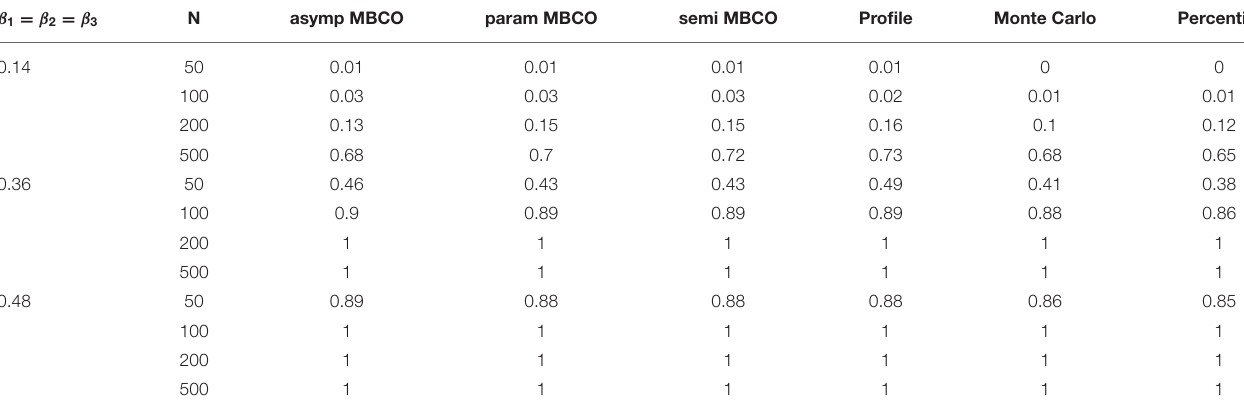
100 1 1 1 1 1 1 200 1 1 1 1 1 1 500 1 1 1 1 1 1 The β coefficients values 0.14, 0.36, and 0.48 correspond to the R 2 = 0.02 (“small”), 0.13 (“medium”), and 0.26 (“large”) according to Cohen (1988)’s general guideline, respectively. asympMBCO,asymptoticMBCOLRT;paramMBCO,parametricbootstrapMBCOLRT;semiMBCO,semi-parametricbootstrapMBCOLRT;Profile,Profile-LikelihoodCI;MonteCarlo, Monte Carlo CI; Percentile, Percentile non-parametric bootstrap.